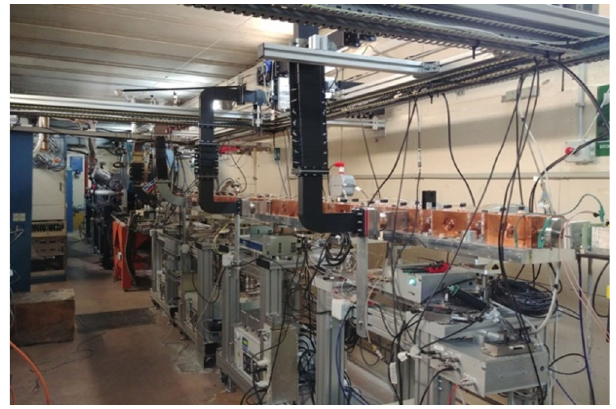
FIG. 9. TOP-IMPLART 35 MeV segment currently in